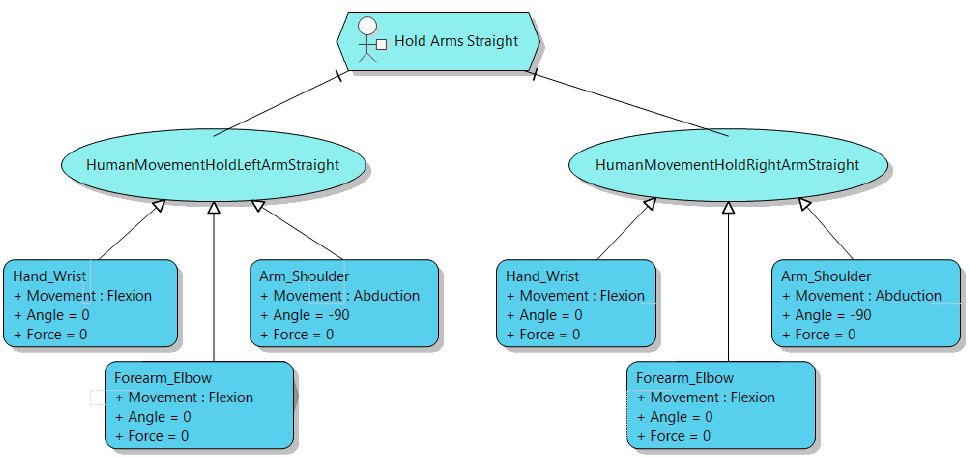
Figure 9. The upper limb rehabilitation presentation model.